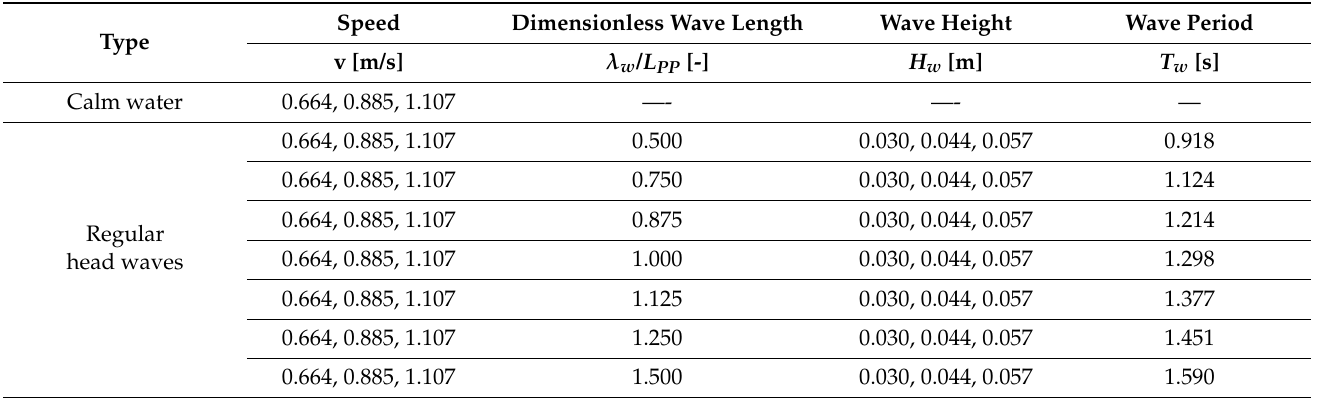
Table 2. Test case overview in